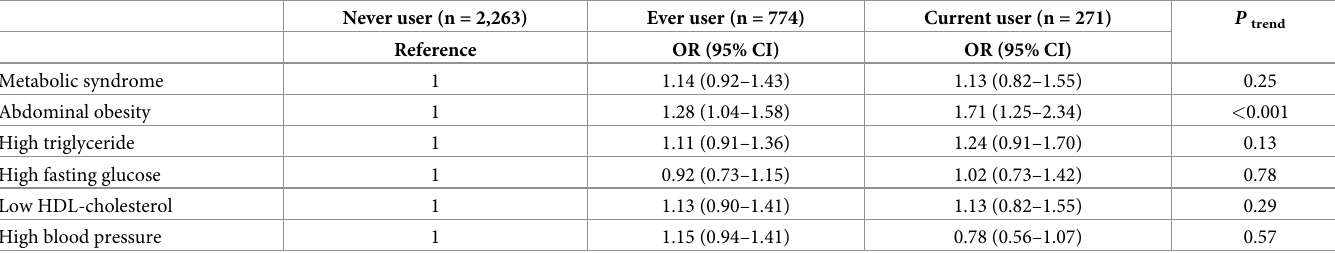
Table 5. Association between metabolic syndrome and electronic cigarette exposure among active smokers (n =